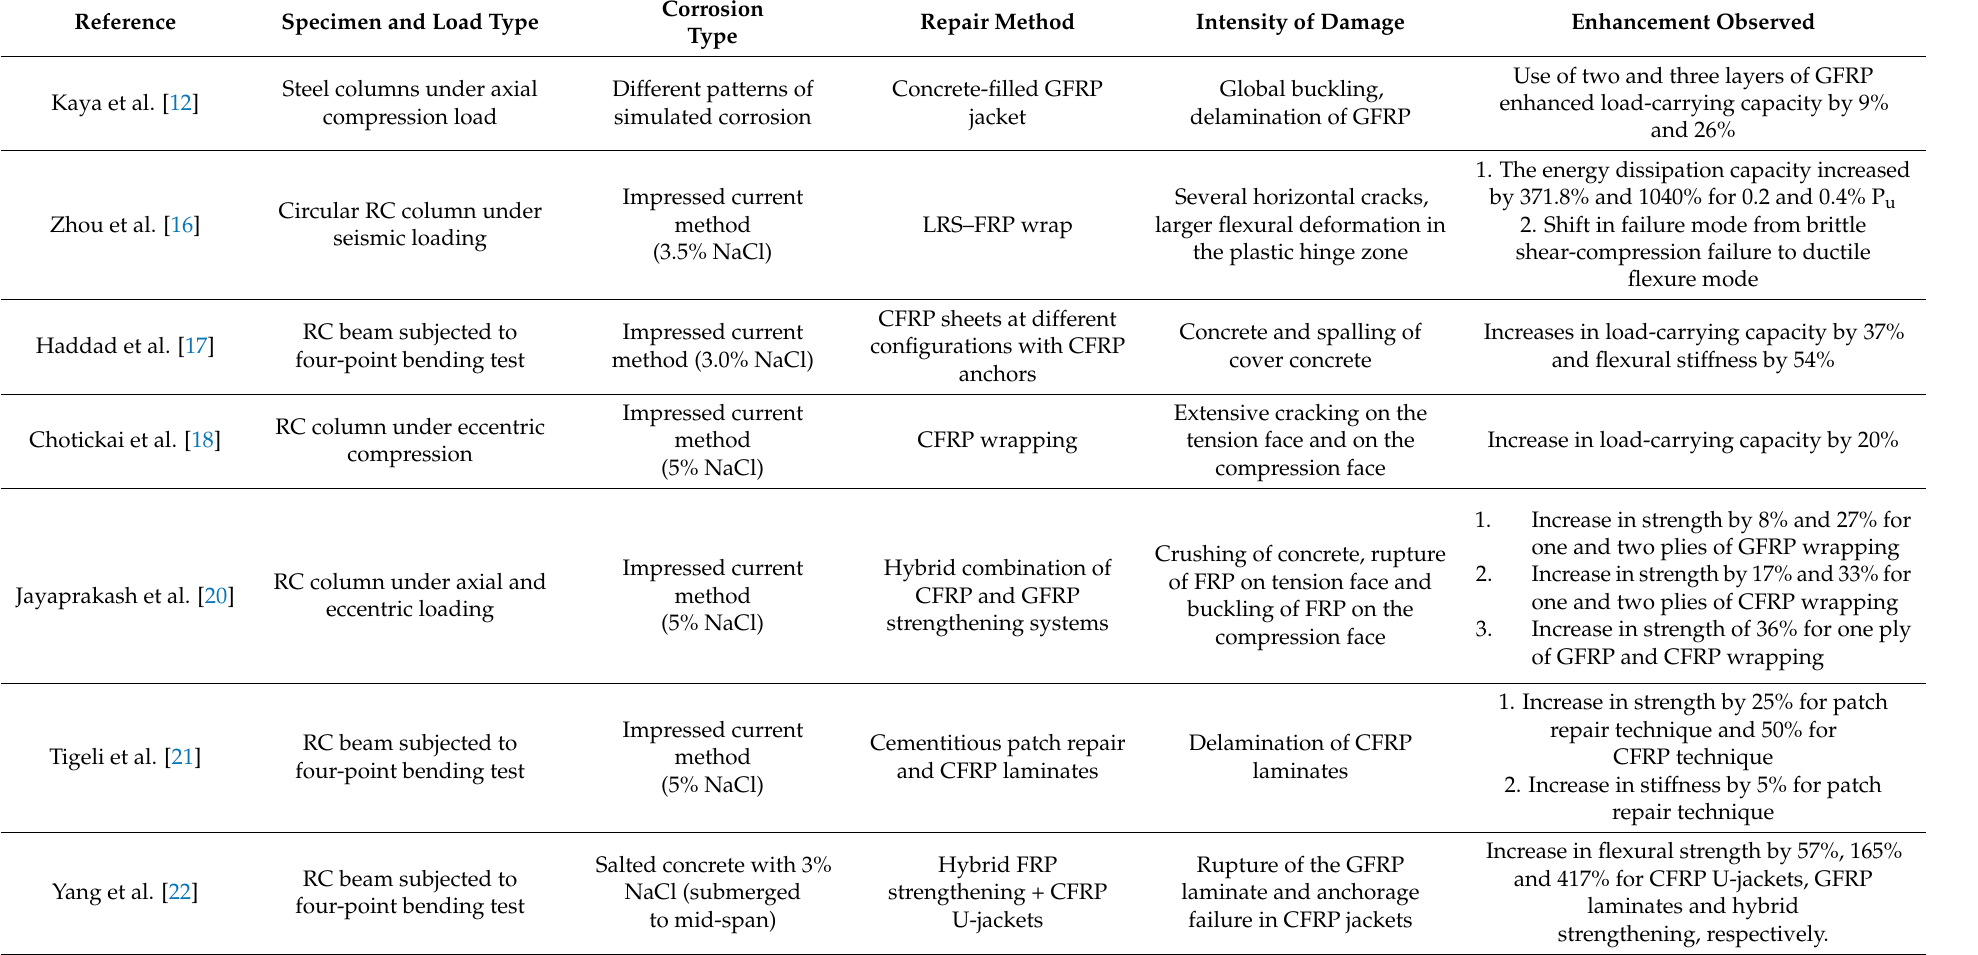
Table 2. Summary of studies on the retrofitting of corroded RC